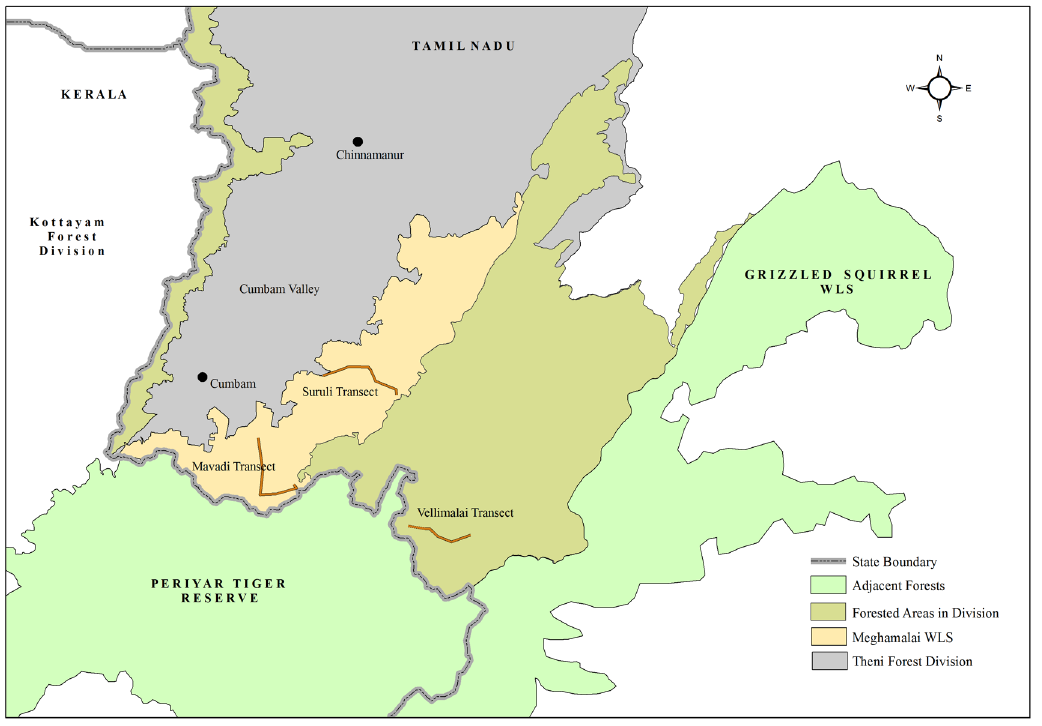
Figure 1. Map of Meghamalai showing belt transects used for sampling